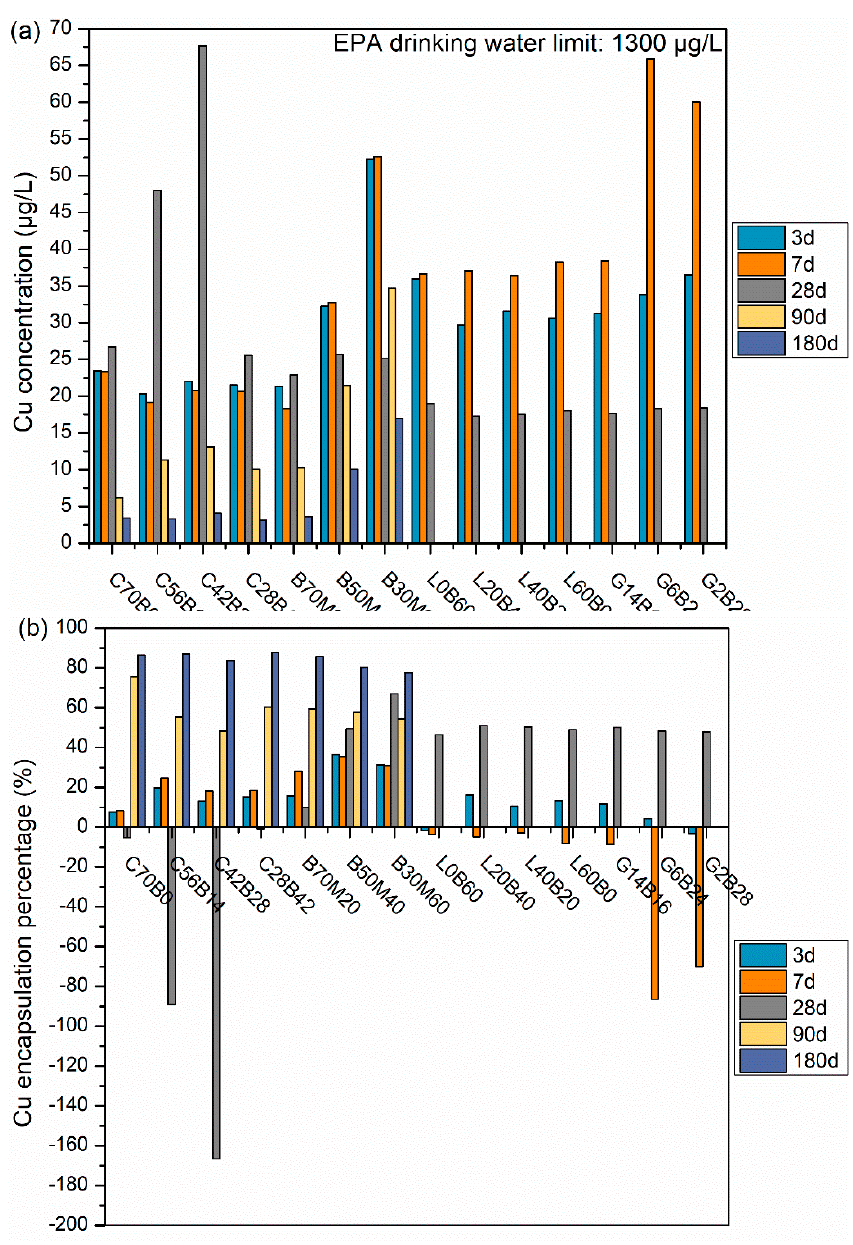
Figure 6. The ( a ) Cu concentration and ( b ) encapsulation percentage for the leachate in all groups at all ages.